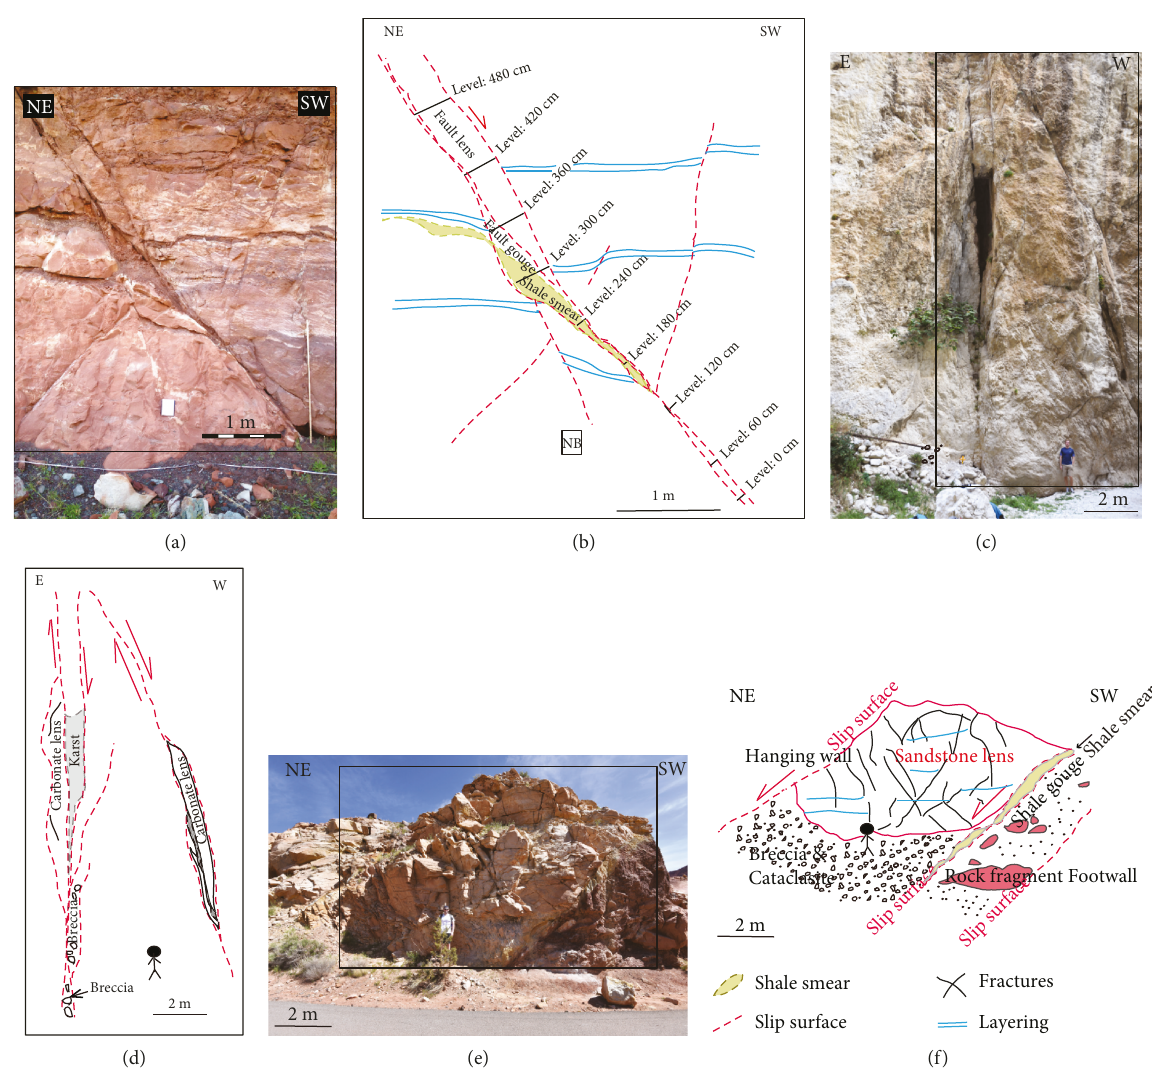
Figure 2: (a, b) Pictures of the outcrop with its sketch illustrating the method for measuring fault core thickness at the outcrop and on photos. The data collection started at the fault position on the scanline and fault core thickness (black lines) was measured perpendicular to fault walls at regular increments (levels) along fault height, in this case, every 60 cm. After Johannessen [70]. Note that the upper part of the fi gure might be considered as two faults with separate fault cores or splays of the same fault cropping out a lens. NB in (b) stands for notebook. (c – f) Examples of fault rocks (pictures and sketches) in the studied fault cores for carbonate rocks of Maiella and siliciclastic rocks of Utah. Multiple slip surfaces, carbonate lenses, karst (not included in the measurements), and breccia are among the structures found in the fault core of carbonate rocks in the strike-slip fault in Maiella in (c) and (d). Note the presence of several slip surfaces and shaley gouge with rock fragments as well as breccia and cataclasite in a normal fault (R-191) in (e) and